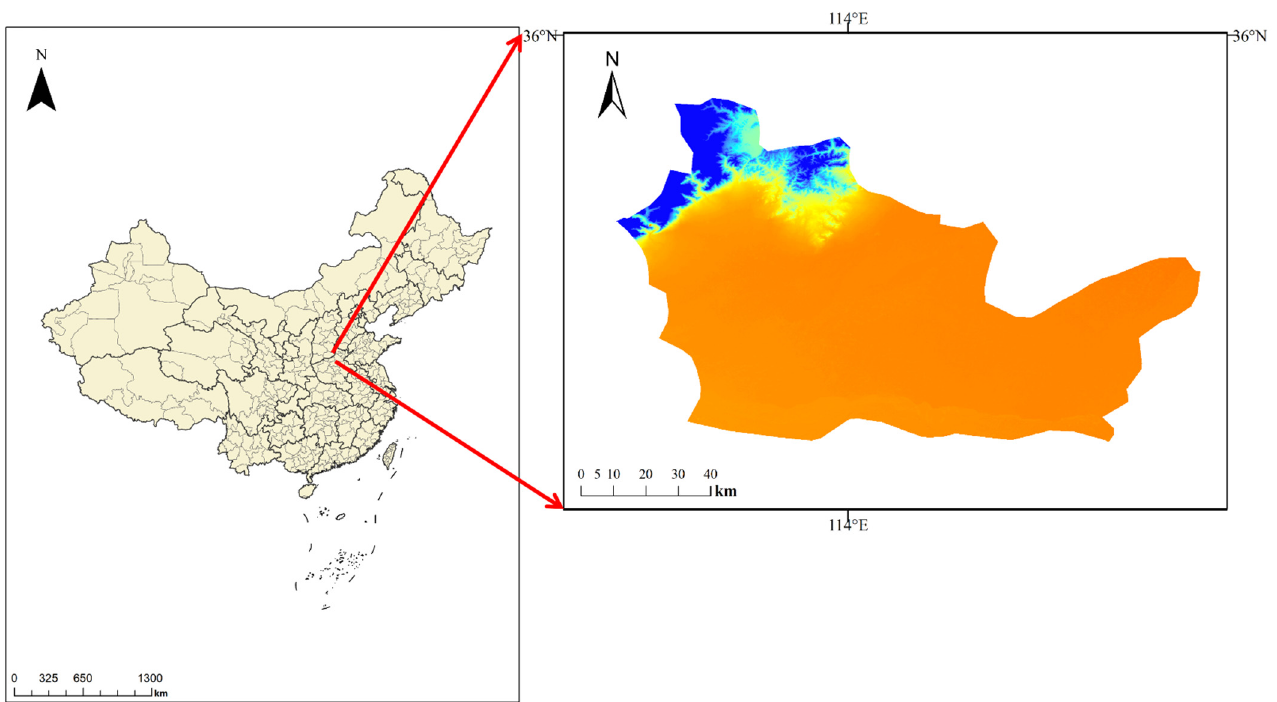
Figure 1. Mapping of the sampling site.